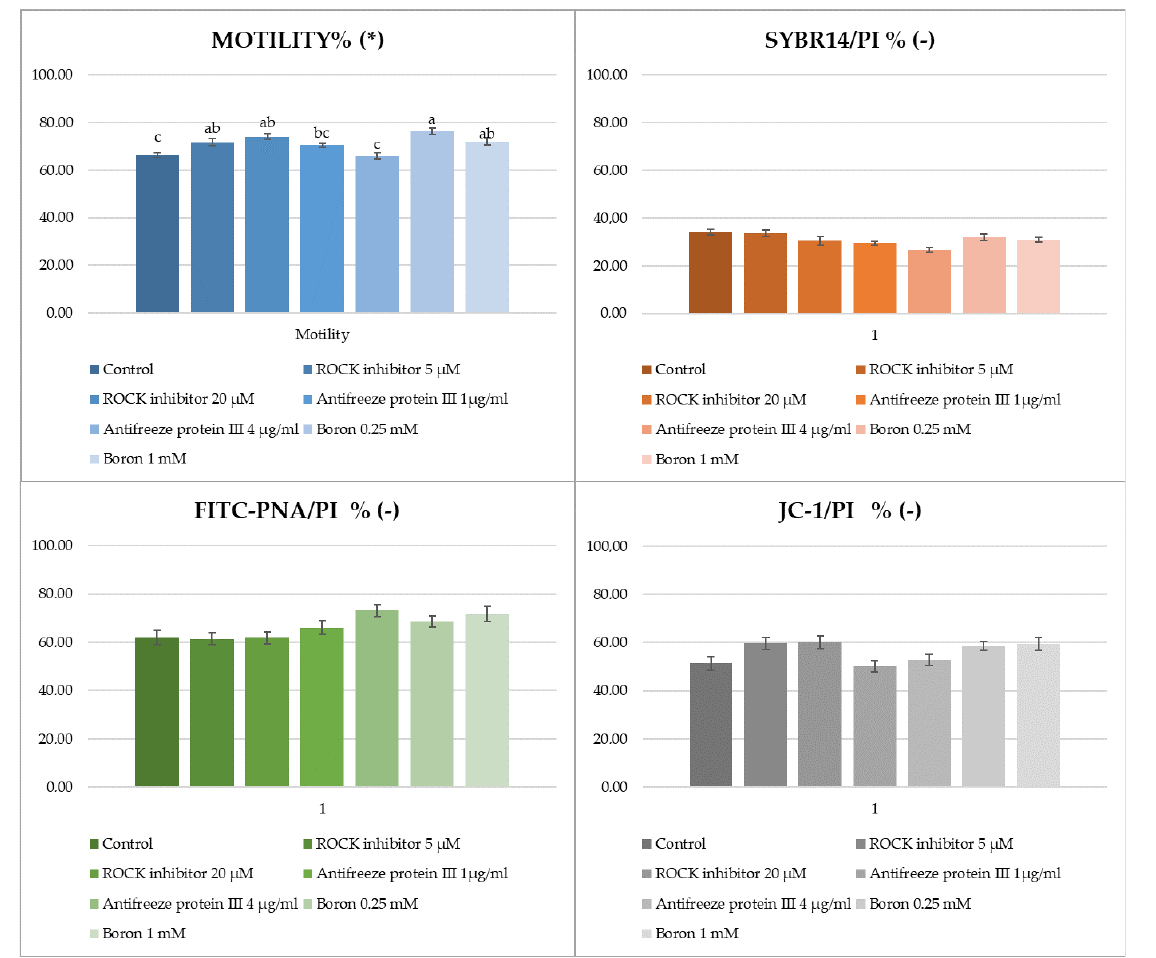
Figure 4. Findings of post-thawed motility, plasma membrane integrity (SYBR14/PI), acrosomal integrity (FITC-PNA/PI), and mitochondrial activity (JC-1/PI) (%) of Ankara buck semen frozen with different additives ( ± SH). (*): The letters a, b, c in the same column represents the statistical differences ( p < 0.01). (-): Not significant ( p > 0.05).